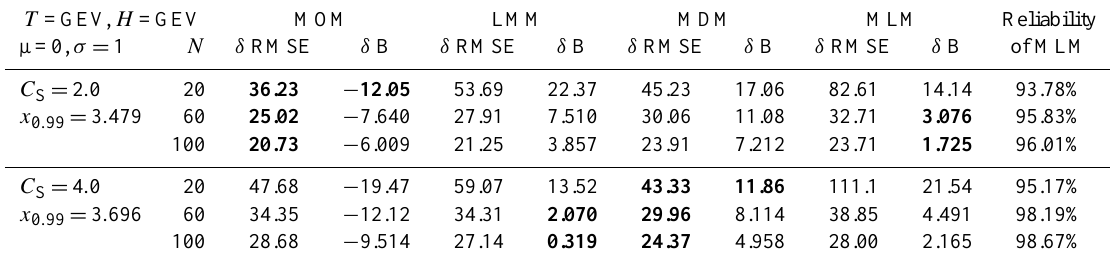
Table 6. Relative accuracy [ % ] of ˆ x 0 . 99 for a sample from GEV, assuming GEV model. T =GEV, H =GEV MOM LMM MDM MLM Reliability µ=0, σ = 1 N δ RMSE C S = 2 . 0 x 0 . 99 = 3 . 479 60 C S = 4 . 0 x 0 . 99 = 3 .